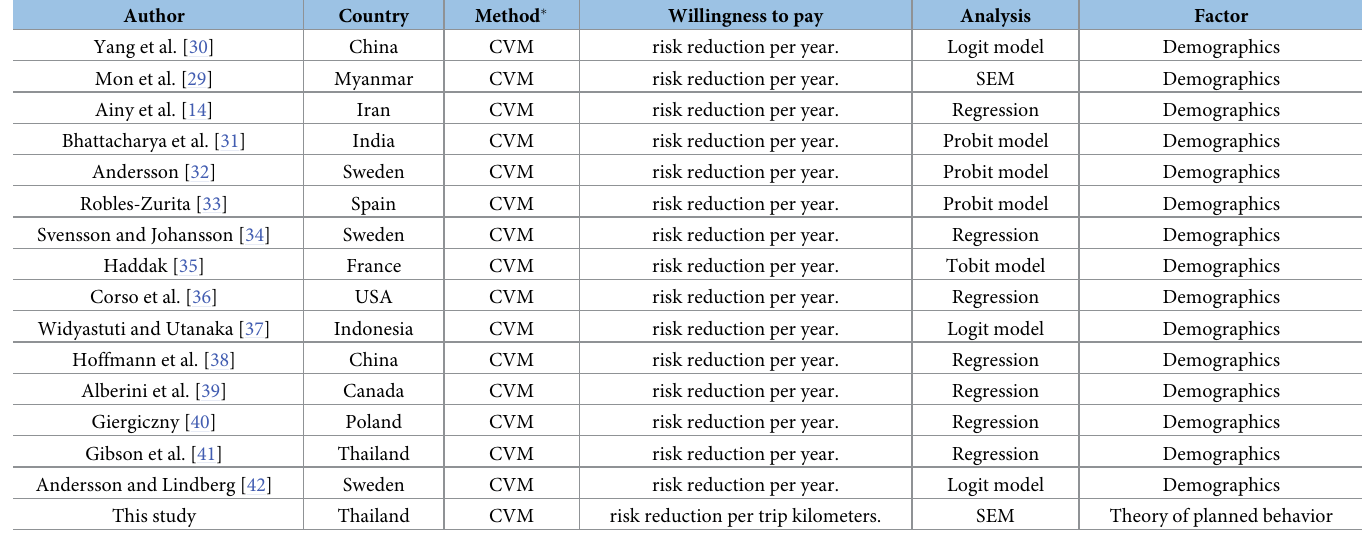
Table 1. Previous studies on willingness to pay with contingent valuation